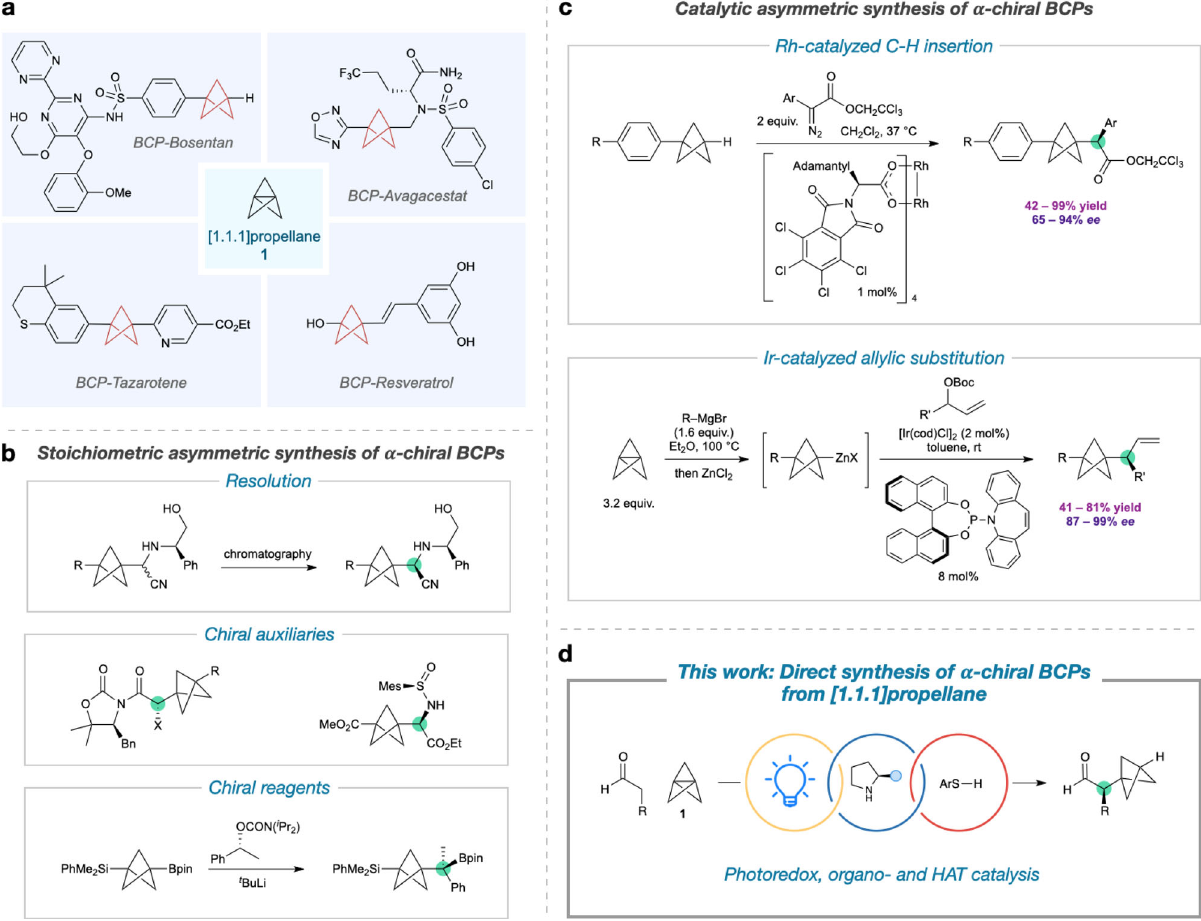
Fig. 1 Synthesis of α -chiral bicyclo[1.1.1]pentanes. a Examples of bicyclo[1.1.1]pentanes (BCPs) in pharmaceutical research. The near-ubiquitous precursor is [1.1.1]propellane ( 1 ). b Current approaches to α -chiral bicyclo[1.1.1]pentanes typically require the use of chemical resolution, or stoichiometric